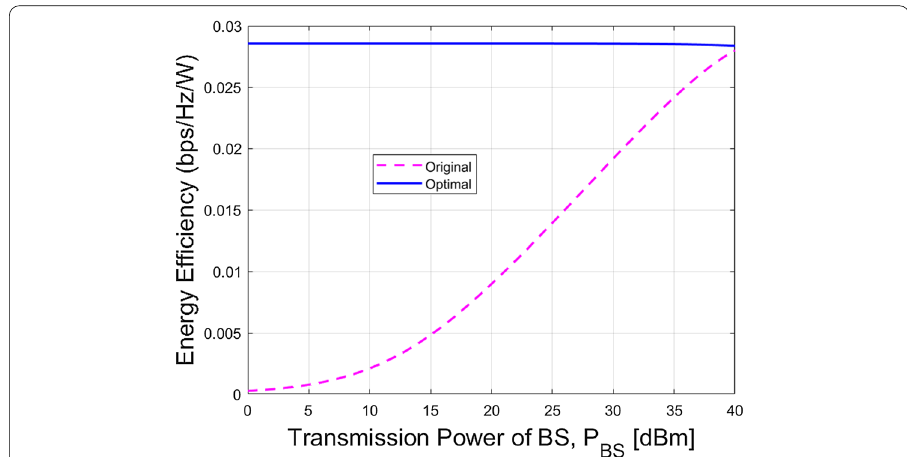
Fig. 8 Energy efficiency vs. transmission power of BS comparison in downlink